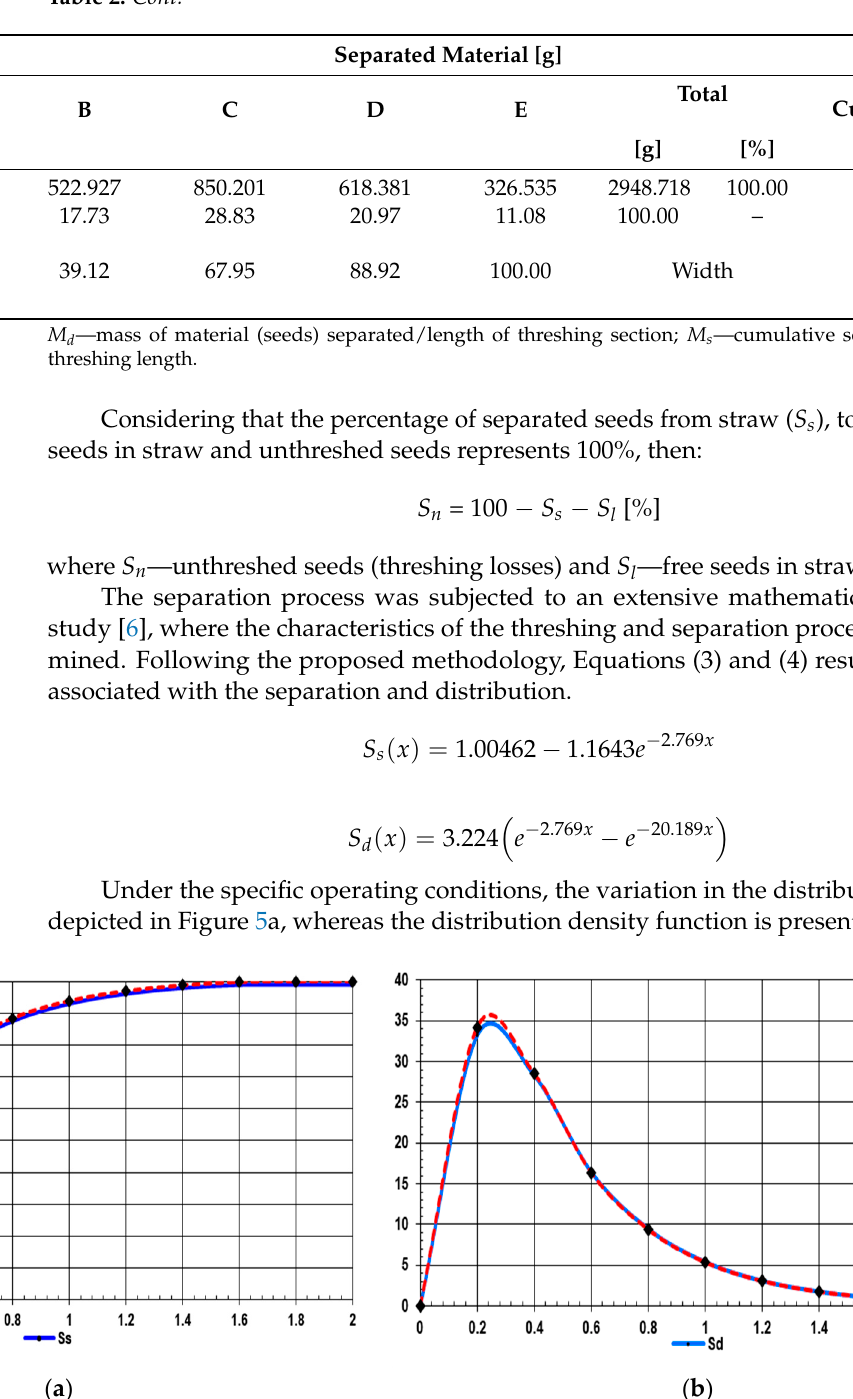
Figure 5. Variation in the distribution functions. ( a ) Function of separated seeds S s . ( b ) Function of the distribution density, S d , along the threshing apparatus length L (where: ♦ experimental points;